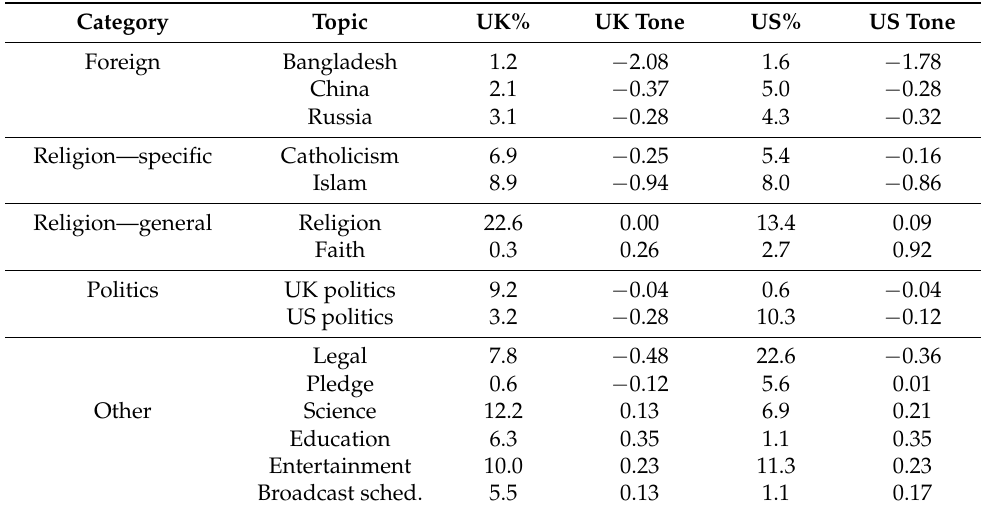
Table 4. Topic model: the average tone of articles about a topic by country.